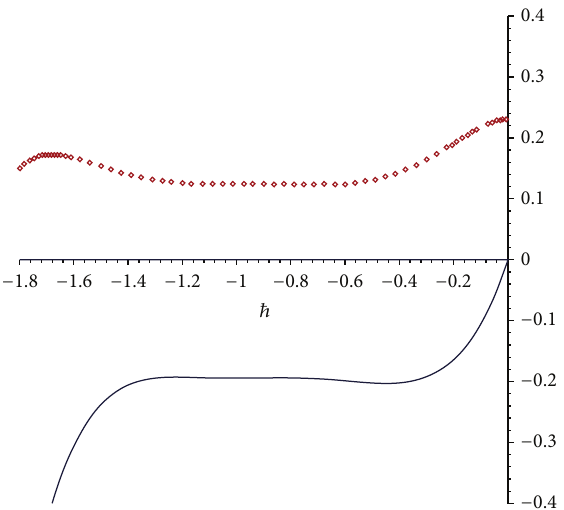
Figure 1: The ℎ -curves for the 7th-order of HAM approximation of 𝑢(0, 𝜋/2, 0.5, ℎ) for Example 1; dotted line: real part of approxima- tion; solid line: imaginary part of